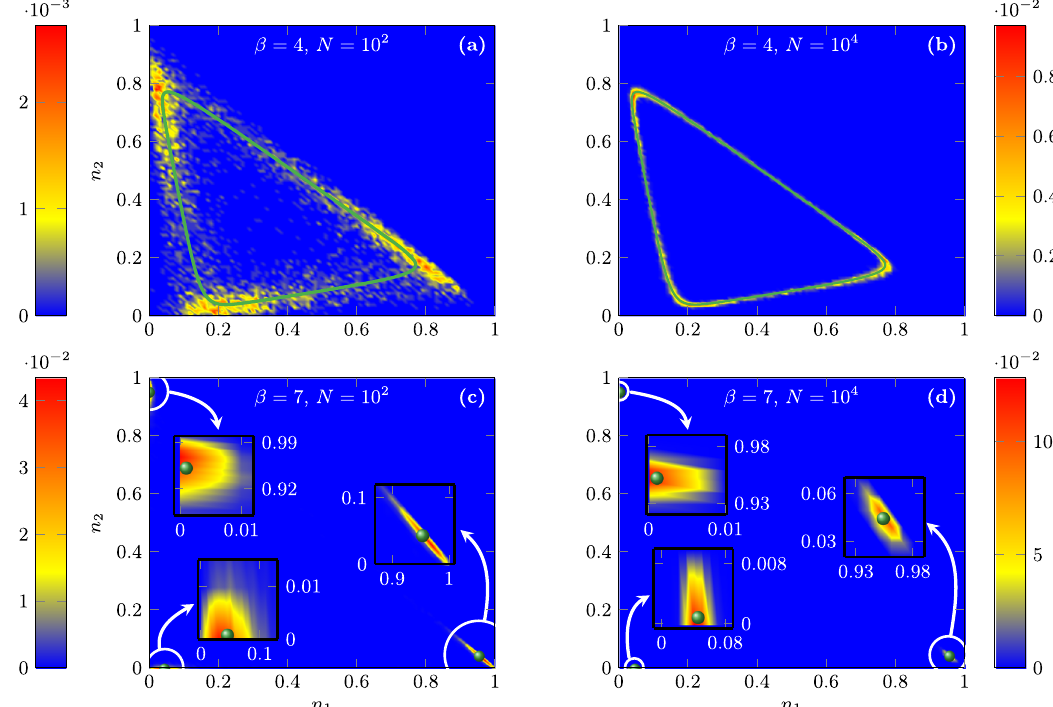
FIG. 9. Joint probability distribution P f n 1 ð t Þ ; n 2 ð t Þg at β ¼ 4 in (a),(b) and at β ¼ 7 in (c),(d) for system sizes N ¼ 10 2 and 10 3 at time t ¼ 20 . The plots are created using a grid of dimension 101 × 101 that specifies the set of initial conditions. For comparison, in all plots the long-time MF solution (green solid line above, green closed circles below) is overlaid.